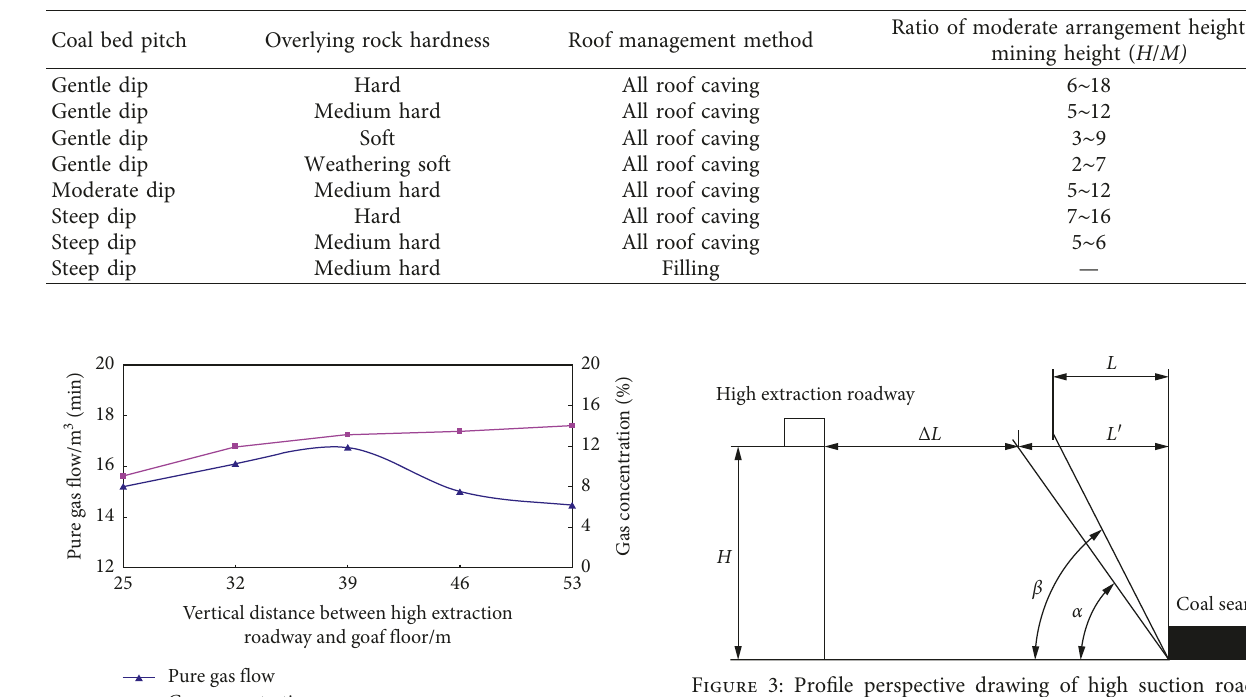
Table 2: Moderate arrangement height of the high suction roadway.